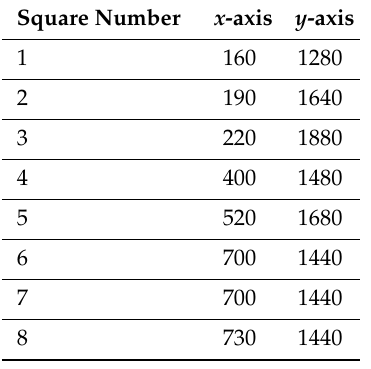
Table 3. Coordinate information of symbol “ ㄧ ”.